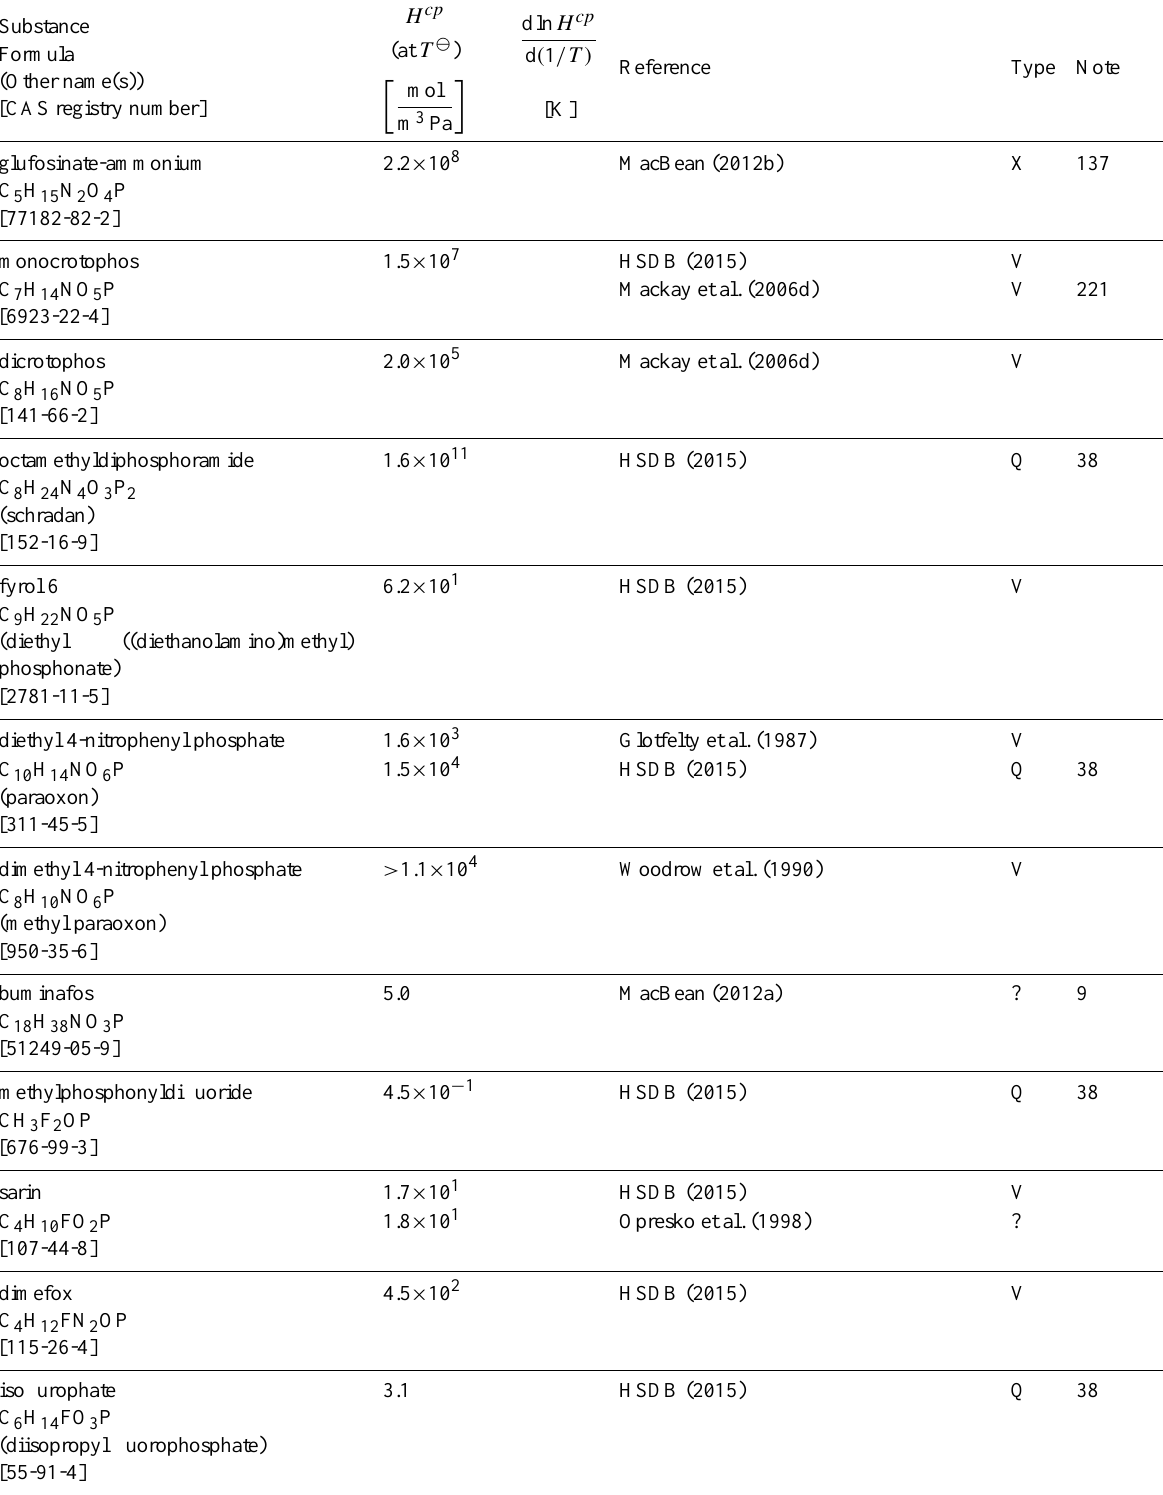
Table 6: Henry’s law constants for water as solvent